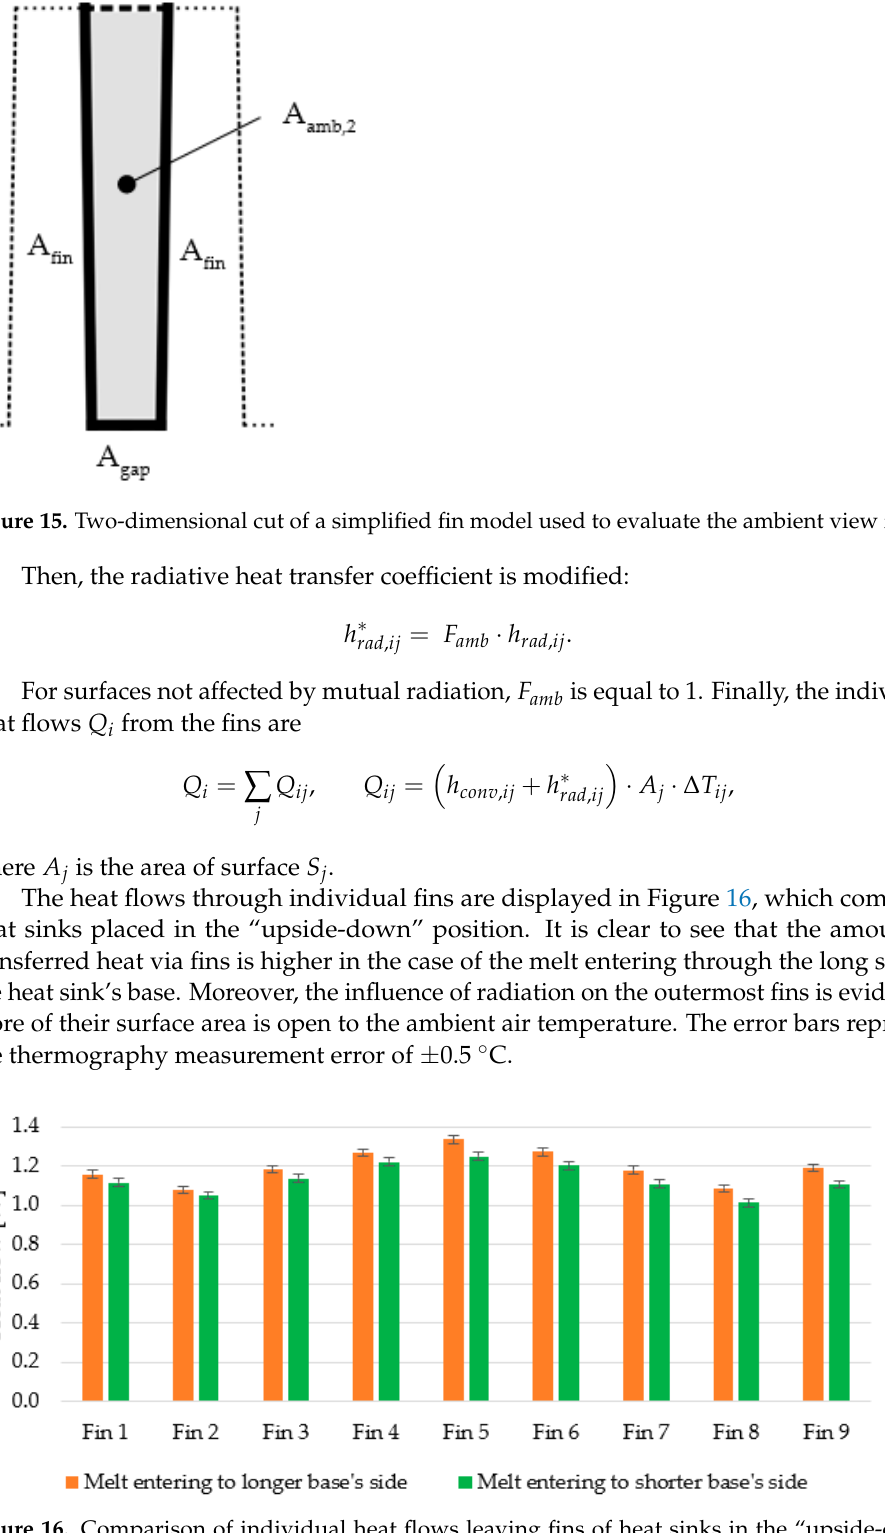
Figure 17. Total calculated heat flow leaving fins for all configurations of conducted measure- ments. As far as different positions of the same heat sink are concerned, the difference of up to 2% is negligible and can be explained by the measurement error of the thermal imagery and by the assumptions on the calculation procedure. One of those is the isothermal sur- face, which in our case was not met (the average difference between maximal and minimal measured temperature on the fins’ tops across all measurements is 3.5 °C). Furthermore, heat transfer from the heat sink base is not included in the calculations. Comparing the heat sinks with different melt flow, a 6–7% heat flow drop can be observed. This leads to the conclusion that heat sinks made with the entry leading to the longer side of the base and therefore parallel to the fins transfer heat more efficiently. 5. Conclusions